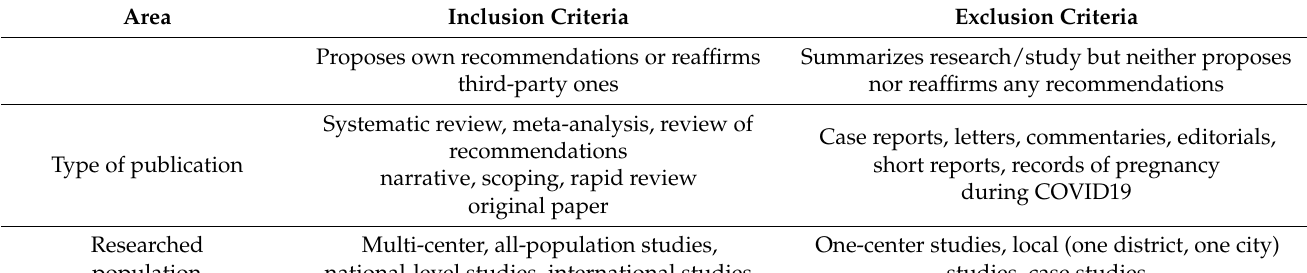
Table 1. Inclusion and exclusion